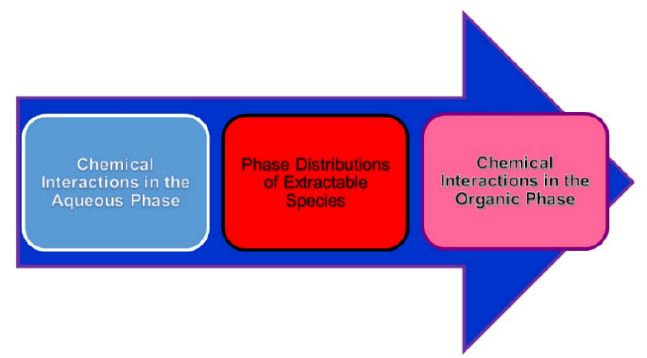
Figure 7. Process of solvent extraction.